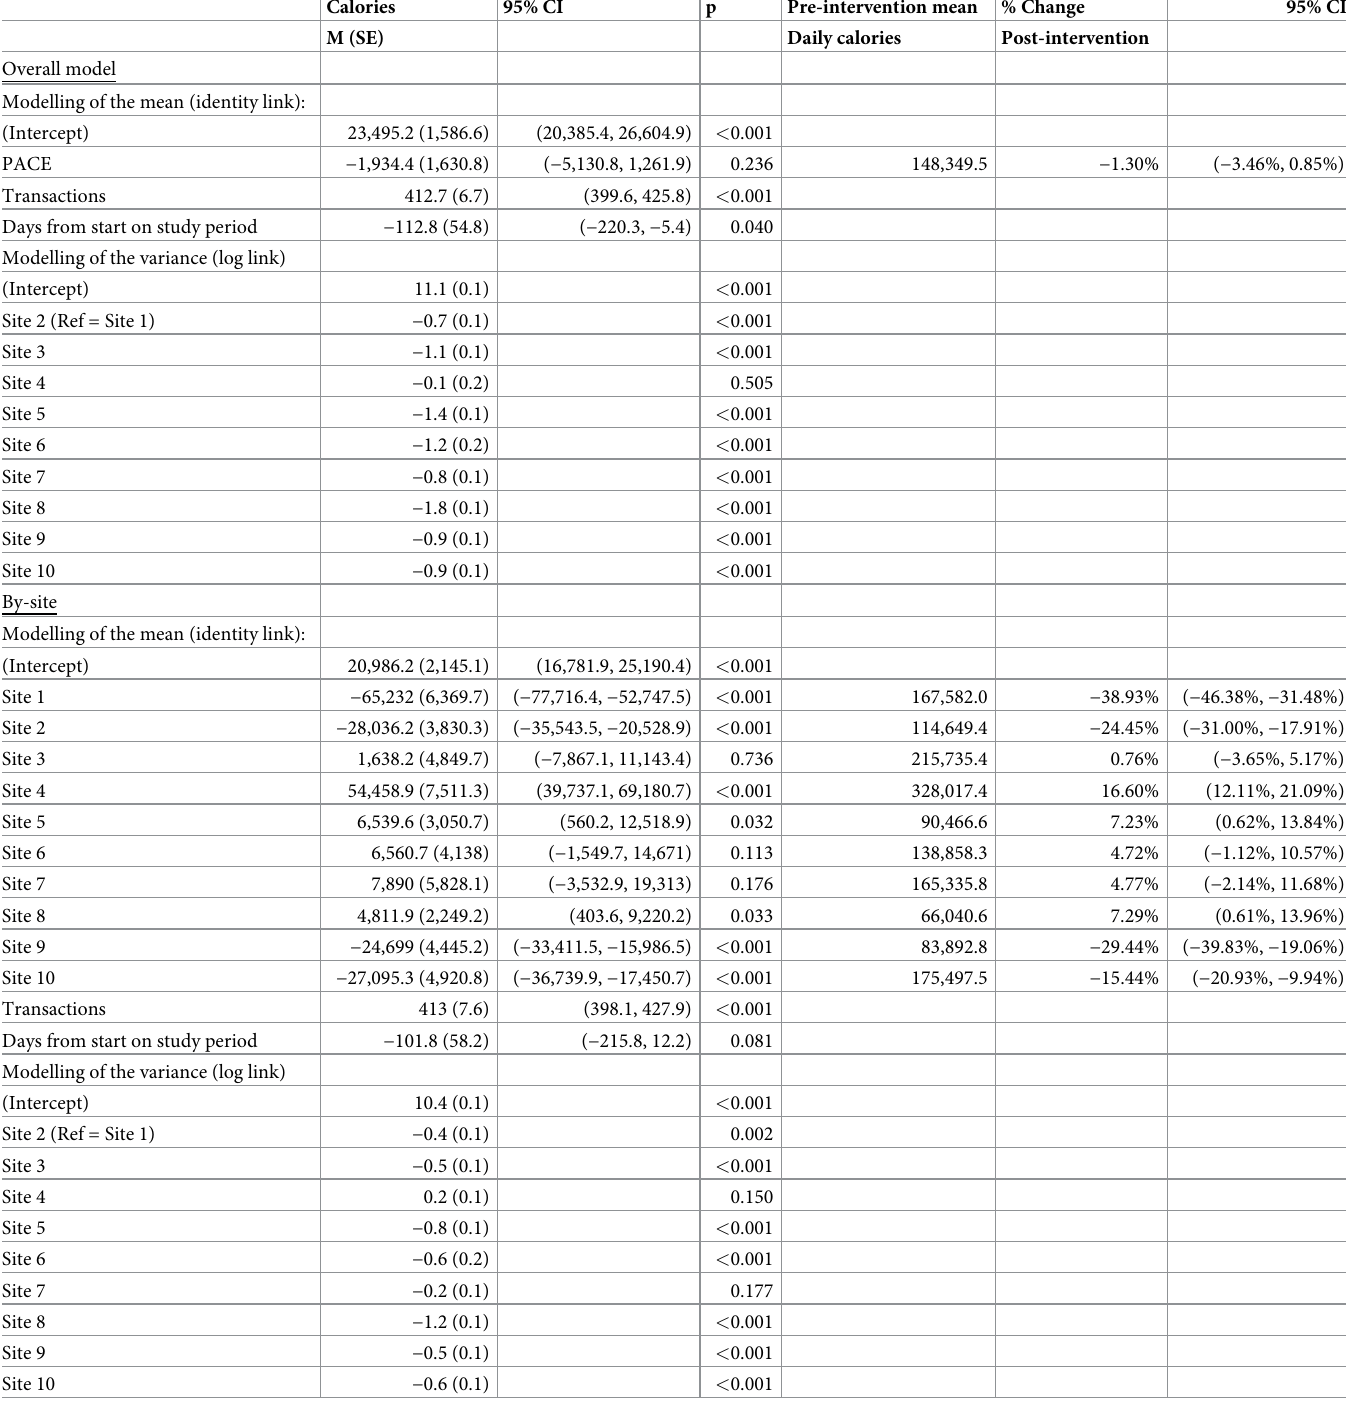
Table 3. Full model results for the primary